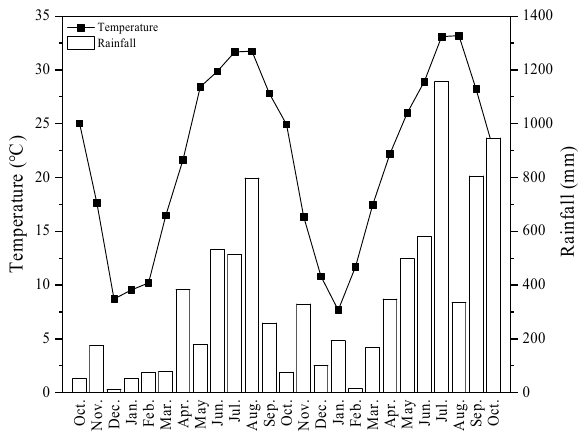
Figure 1. The monthly average rainfall and temperature from 2014 to 2016.